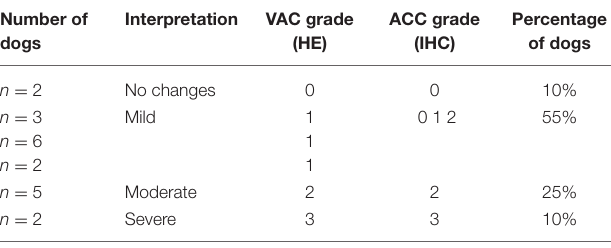
TABLE 4 | Summary of grading of distal tubuli epithelial vacuolization and HES accumulation in 20 dogs. Number of dogs